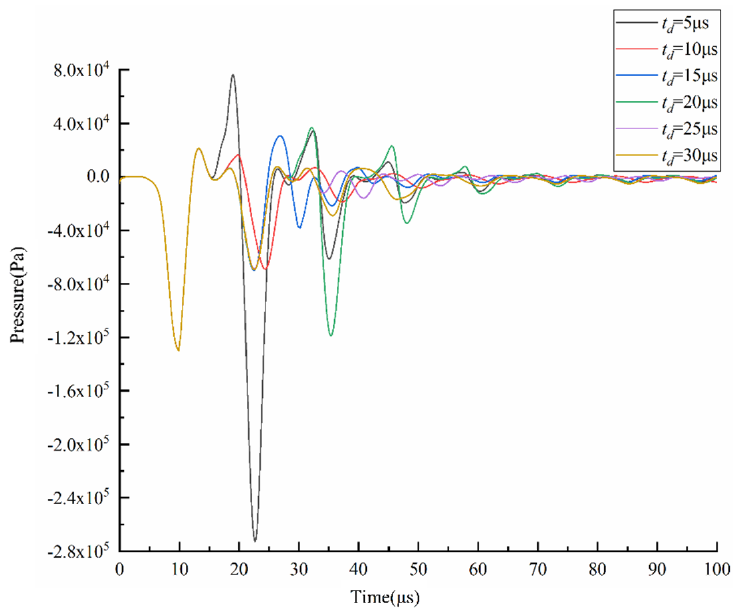
Figure 10. Trapezoidal waveform.